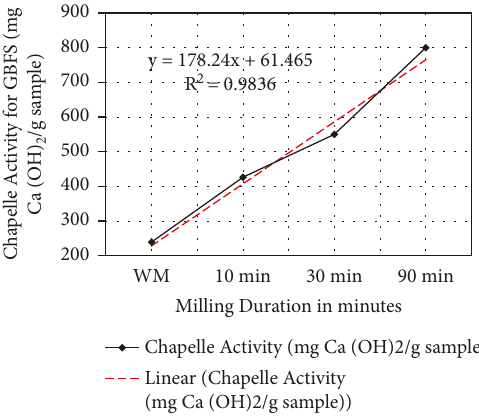
Figure 10: Chapelle activity of